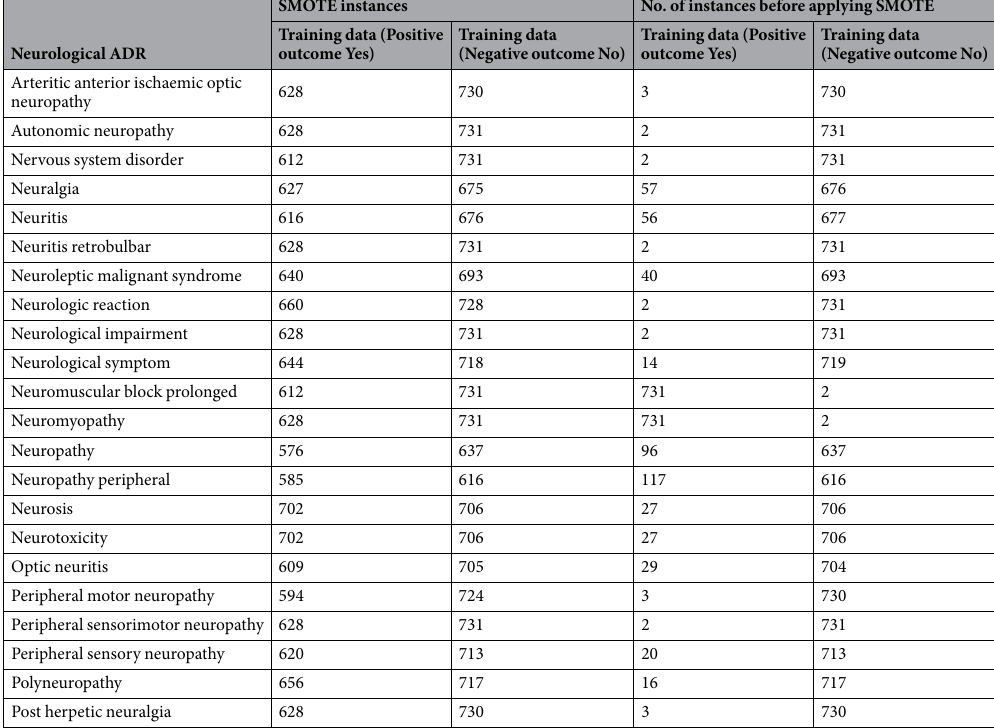
Table 10. Provides the information about the number of training data instances obtained after applying SMOTE for each of the 22 neurological